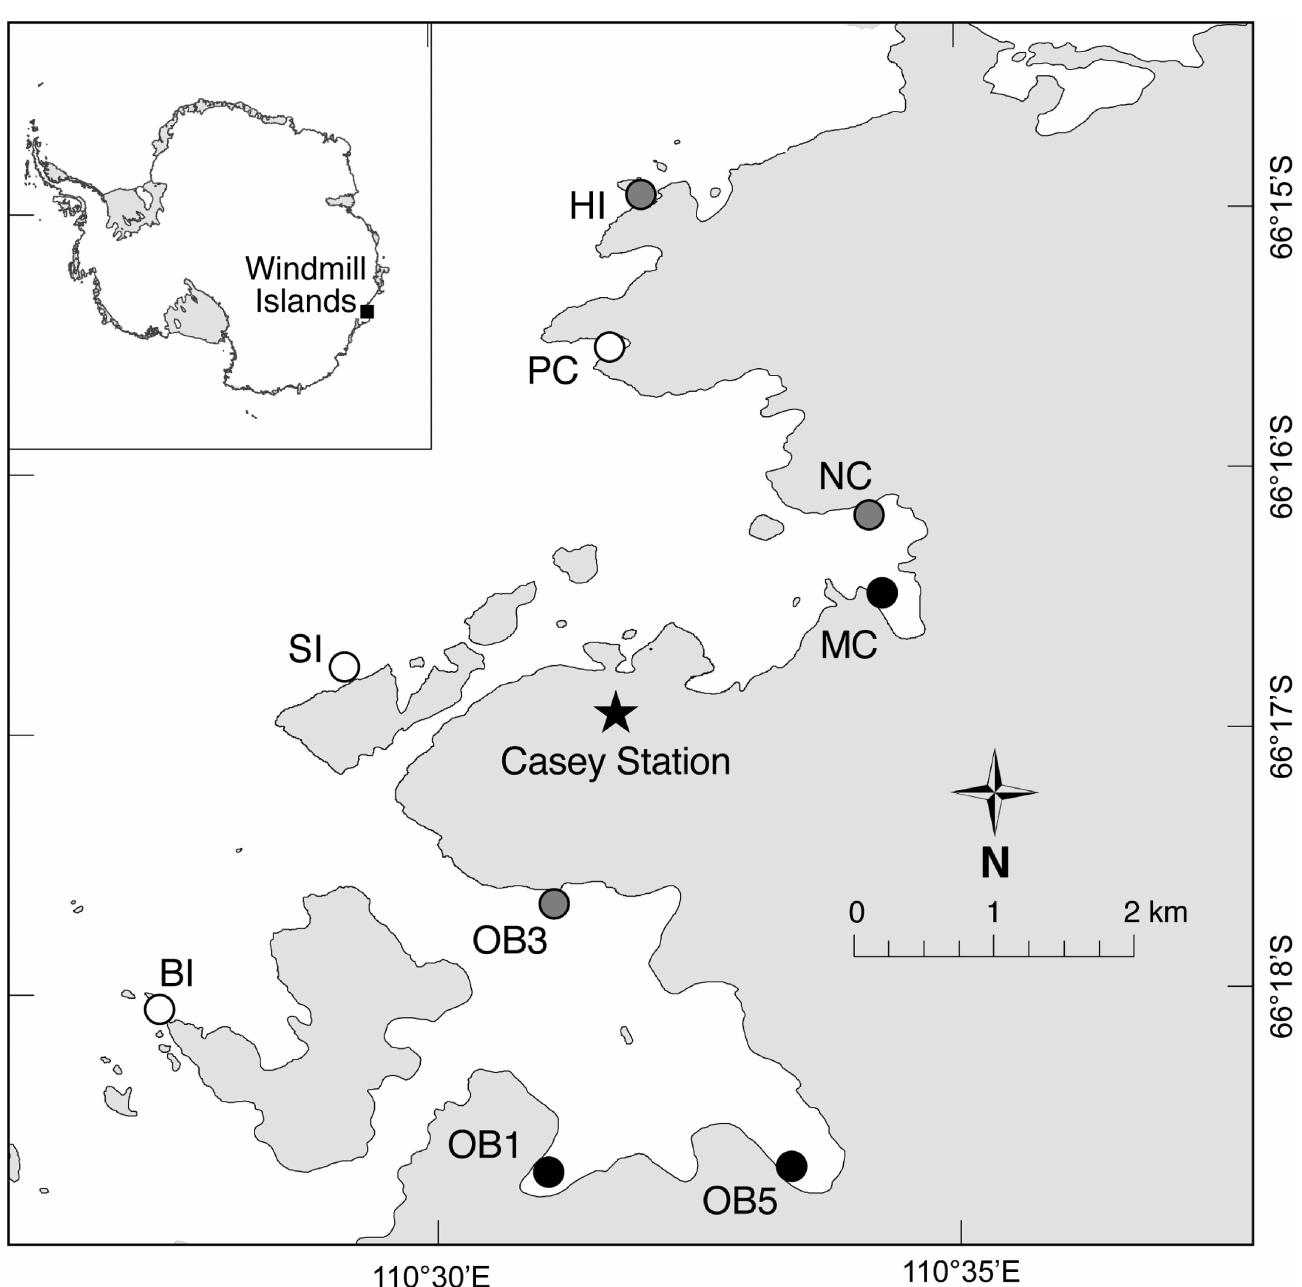
Fig 1. Map of study region in the Windmill Islands, located on the coast of Wilkes Land, East Antarctica. Casey Station is marked with a star. Abbreviatedsite names correspond to those in Table